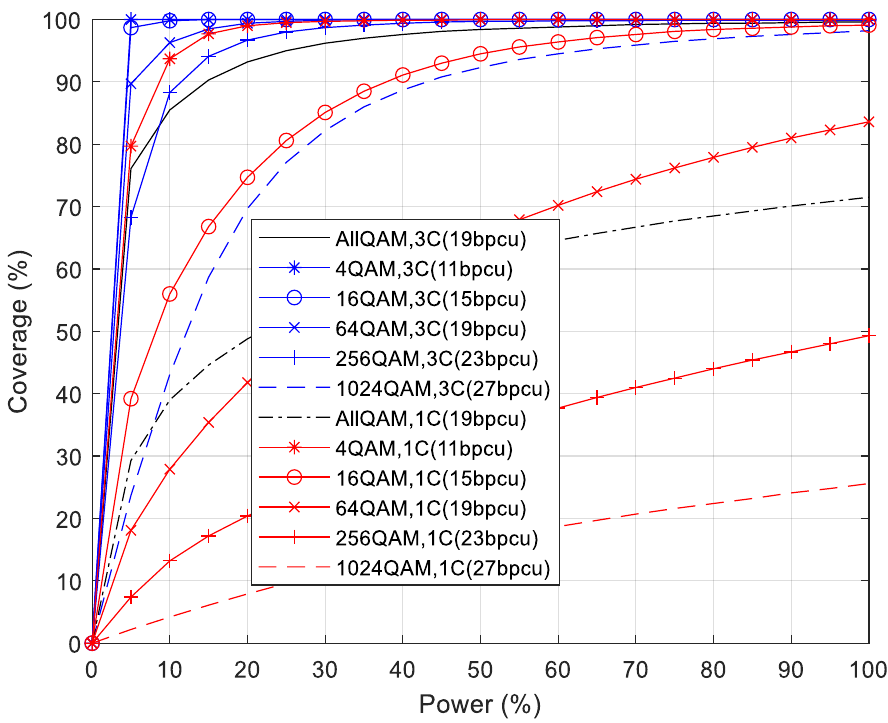
Figure 8. Coverage vs percentage of transmitted power for N a = 2, N sc = 256, N u = 15, N tx = 17 antennas / user and N rx = 16 antennas /